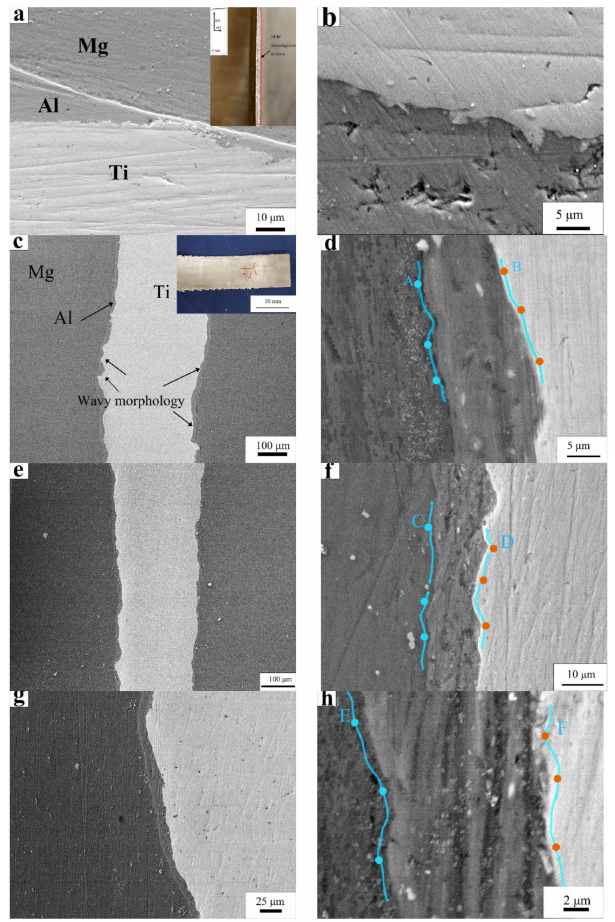
Figure 3. Microstructure and EDS line scanning of Mg-(Al-)Ti sheet rolled at various temperatures: ( a , b ) room temperature (RT); inset shows SEM investigation location, section of (ND-TD) plane, ND, TD and RD, meaning normal direction, transversal direction, and rolling direction ( c , d ) at 200 ◦ C, ( e , f ) 250 ◦ C, and ( g , h ) 300 ◦ C. EDS points are indicated by A–F ( d , e , h ) at a distance of about 1 µ m from the interface, the blue line was the EDS scanning location, and the blue dots and orange dots means the EDS point location.